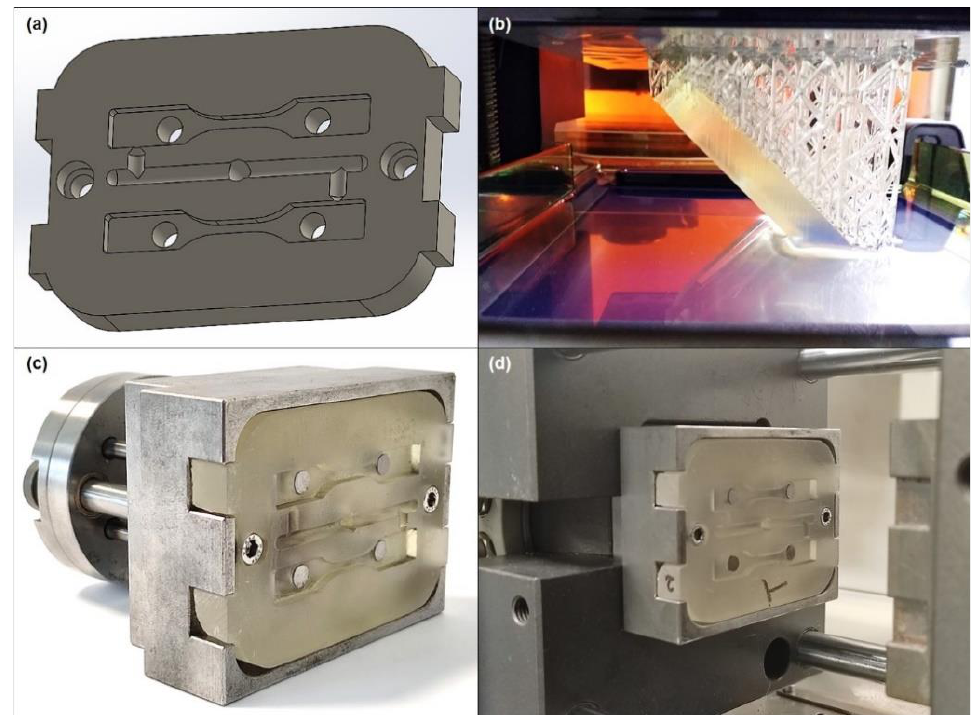
Figure 1. ( a ) Rendering of the mould insert designed; ( b ) insert while printing in the FormLabs 2 SLA 3D printer with HighTemp resin; ( c ) HighTemp mould insert fitting the steel bolster with the ejector system; ( d ) bolster containing a HighTemp insert fitted in the moulding